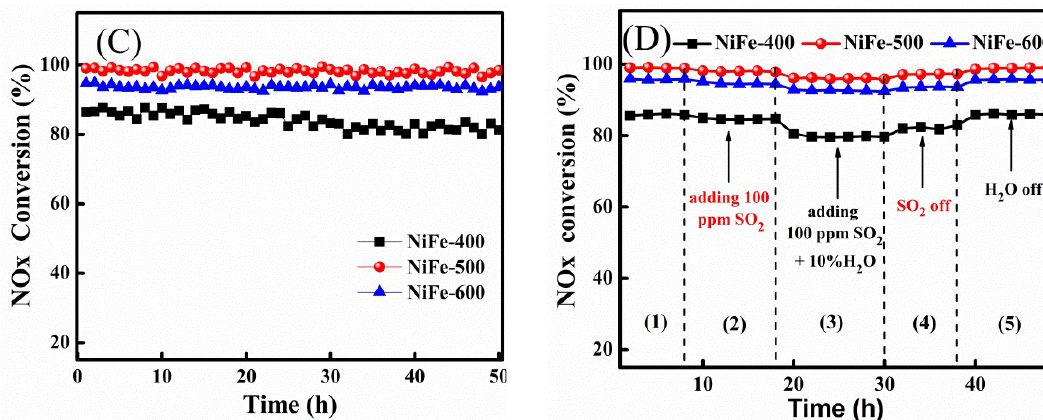
Figure 1. Catalytic performance of the serial NiFe-layered double oxide (LDO) catalysts: ( A ) nitrogen oxide (NO x ) conversion; ( B ) N 2 selectivity; ( C ) stability tests at 300 ◦ C; ( D ) SO 2 /H 2 O resistance tests at 300 ◦ C. Reaction conditions: 600 ppm NO, 600 ppm NH 3 , 5% O 2 , 100 ppm SO 2 (when used), 10% H 2 O (when used), balance N 2 , gas hourly space velocity (GHSV) = 45,000 h − 1 .